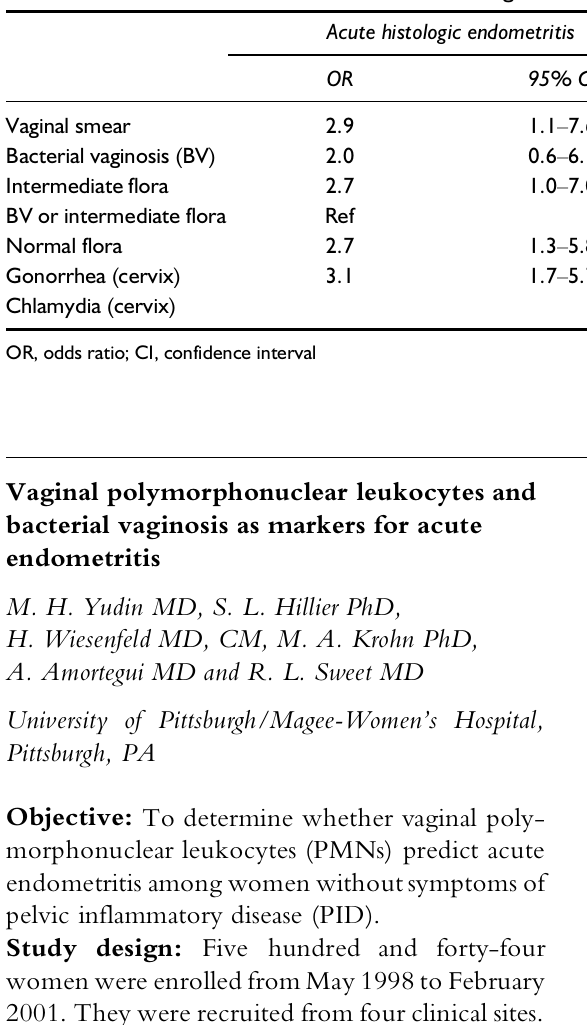
Table 1 Association between endometrisis and vaginal